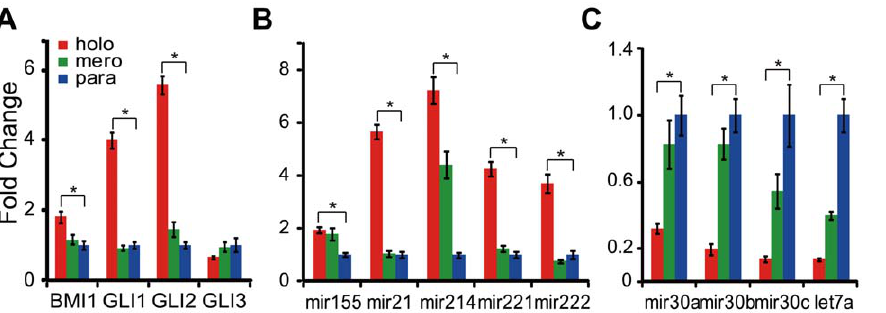
Figure 5. Differential expression of regulatory genes and microRNAs associated with cancer stem cells. BMI1 , GLI1 , and GLI2 were up- regulated in holoclones, while expression of GLI3 showed no significant change among distinct types of colonies (A). The microRNAs were clustered into two groups, which were elevated (B) and repressed (C) in holoclones respectively. All expression values in distinct types of colonies were normalized against those in paraclones (*, p , 0.05).